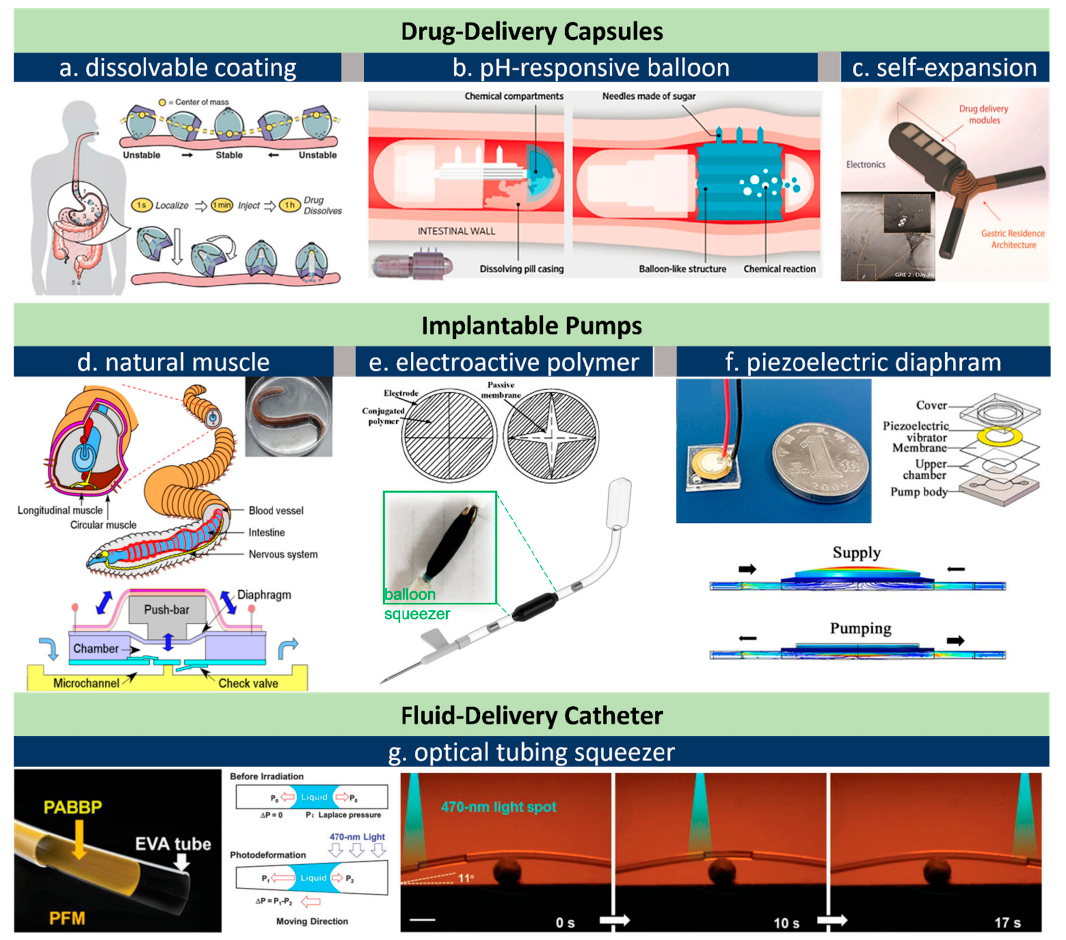
Figure 4. Actuators for drug-delivery uses. ( a ), Spring actuator triggered by dissolvable coating in a tortoise-mimic capsule [52]; ( b ), pH-responsive inflatable balloon actuator for controlled microneedle insertion in RaniPill TM [114]; ( c ), self-expanded arms in a stomach-residing capsule [54]; ( d ), a drug- delivery pump based on worm muscle [116]; ( e ), EAP-based implantable insulin pump (bottom) [117], and an EAP-based diaphragm valve (up) [118]; ( f ), a piezoelectrically driven implantable pump [119]; ( g ), photoresponsive catheter for fluid/drug delivery, scale bar is 2 mm [120]. All images are reproduced or adapted with